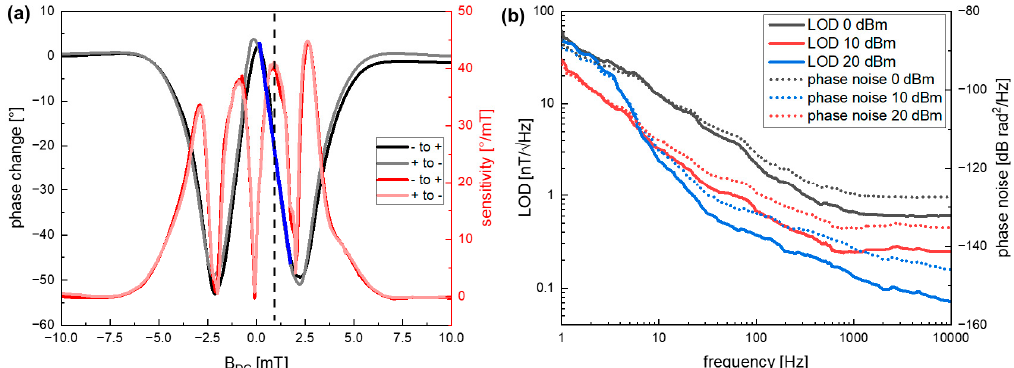
Figure 5. ( a ) The induced phase shift in the sensor with an external magnetic flux density (black) and the direct measurement of the sensitivity with an ac test signal (red) is shown. The highest slope in the phase change occurs at about 0.85 mT and 2.65 mT, resulting in the highest values of sensitivity of up to 45°/mT. A value of 0.85 mT is chosen as a working point (indicated with the dotted line) due to the high sensitivity and the lower field value compared to 2.65 mT. The dynamic range of the sensor is marked with the blue line, showing the linear region of the sensor. The ac signal has an amplitude of 10 µT and a frequency of 10 Hz. ( b ) Measured phase noise (dotted line) and calculated limit of detection (solid line) as a function of the frequency at magnetic saturation for 0 dBm (black), 10 dBm (red), and 20 dBm (blue) input power.